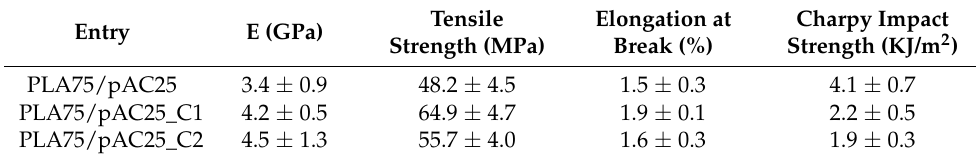
Figure 7. Torque vs time trends for the extrusion of PLA75/pAC25 blends compatibilized with C1 or C2. Table 3. Mechanical properties of the PLA75/pAC25 blends compounded with C1 and C2.